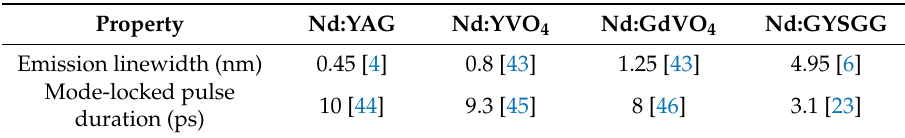
Table 3. Comparison of emission linewidth and SESAM-mode-locked laser pulse duration around 1.06 µ m between Nd:GYSGG and commonly used laser gain